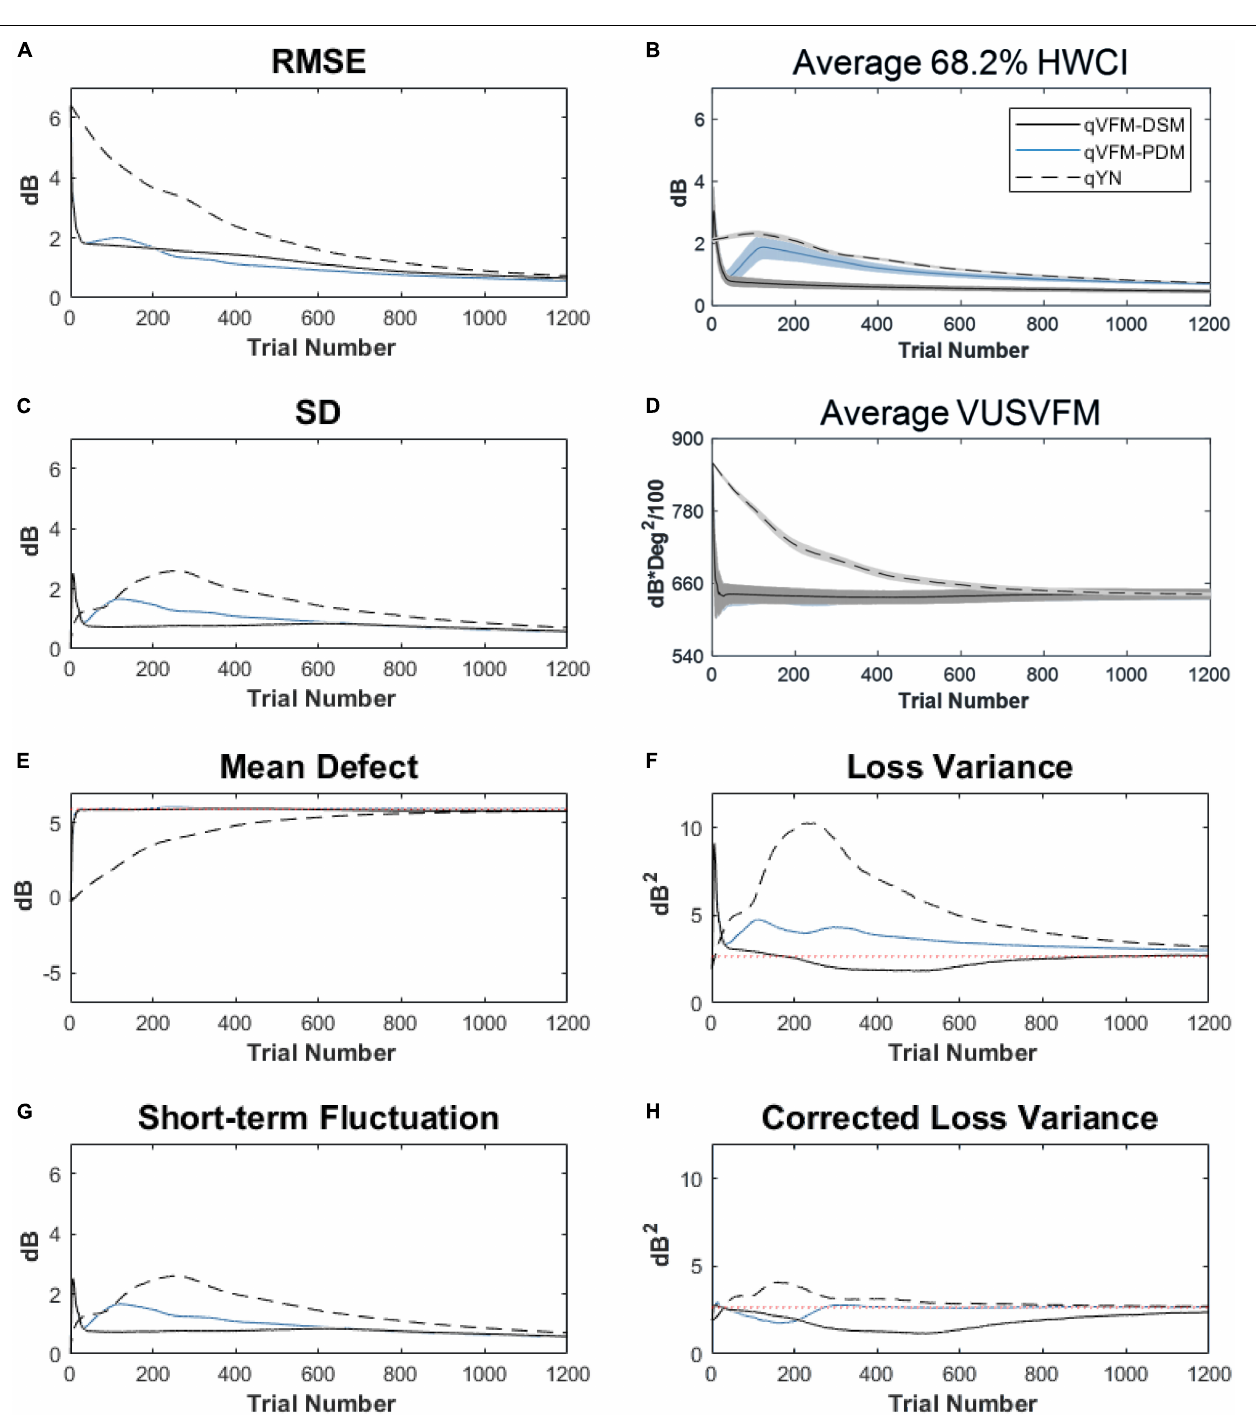
FIGURE 6 | Performance I of the qVFM-DSM, qVFM-PDM and qYN methods in estimating VFM of the simulated glaucoma observer across 200 runs. (A) Average root mean squared error, (B) Average 68.2% HWCI of the estimated VFM, (C) Average standard deviation, (D) Average volume under the surface of the VFM (VUSVFM), (E) Mean defect, (F) Short-term fluctuation, (G) Loss variance, and (H) Corrected loss variance. Results from the qVFM-DSM and qVFM-PDM methods are shown in solid black and blue lines, and results from the qYN method are shown in dashed lines. The true values of the global indices are shown in red dotted lines. For panels (B,D) , shaded regions represent ± 1 SD of the corresponding